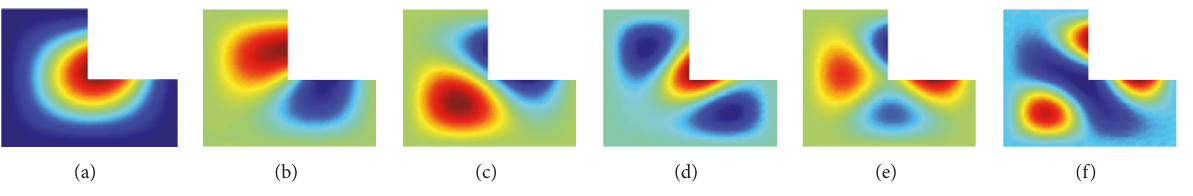
Table 5: Natural frequencies (Hz) for the rectangular plate with double cutouts.